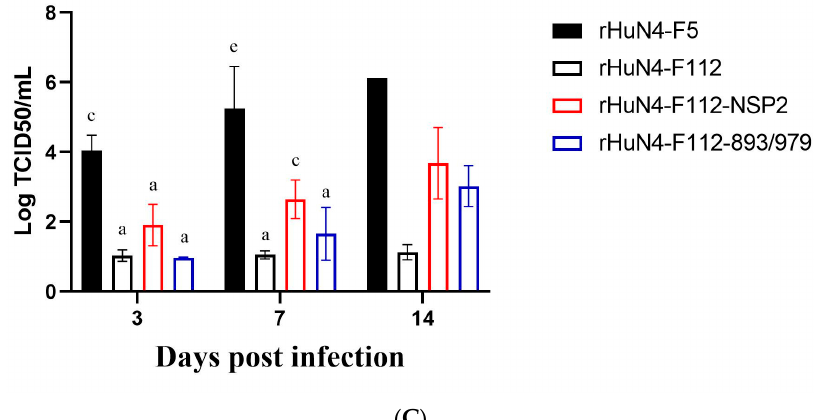
Figure 5. Viremia of each group after infection. The viremia of the chimeric viruses and their parental virus was shown with means ± standard deviations. Results were shown with single alphabet, or a range of alphabets which were represented by the first and last alphabet. The results which share same alphabet mean p ≥ 0.05; results which do not share same alphabet, but have adjacent alphabets with each other mean p < 0.05; results which do not share same alphabet or adjacent alphabets with each other mean p < 0.01.